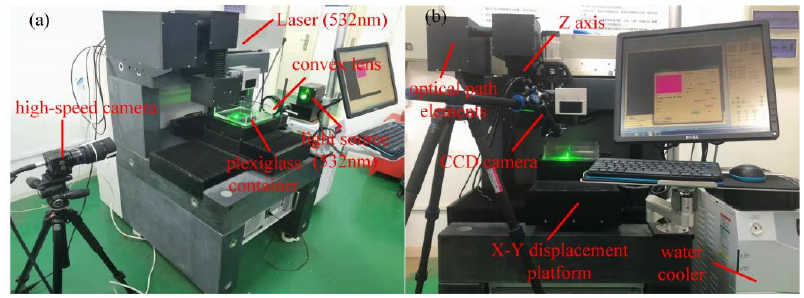
Figure 2. Devices: ( a ) side-view path; ( b ) top-view path.